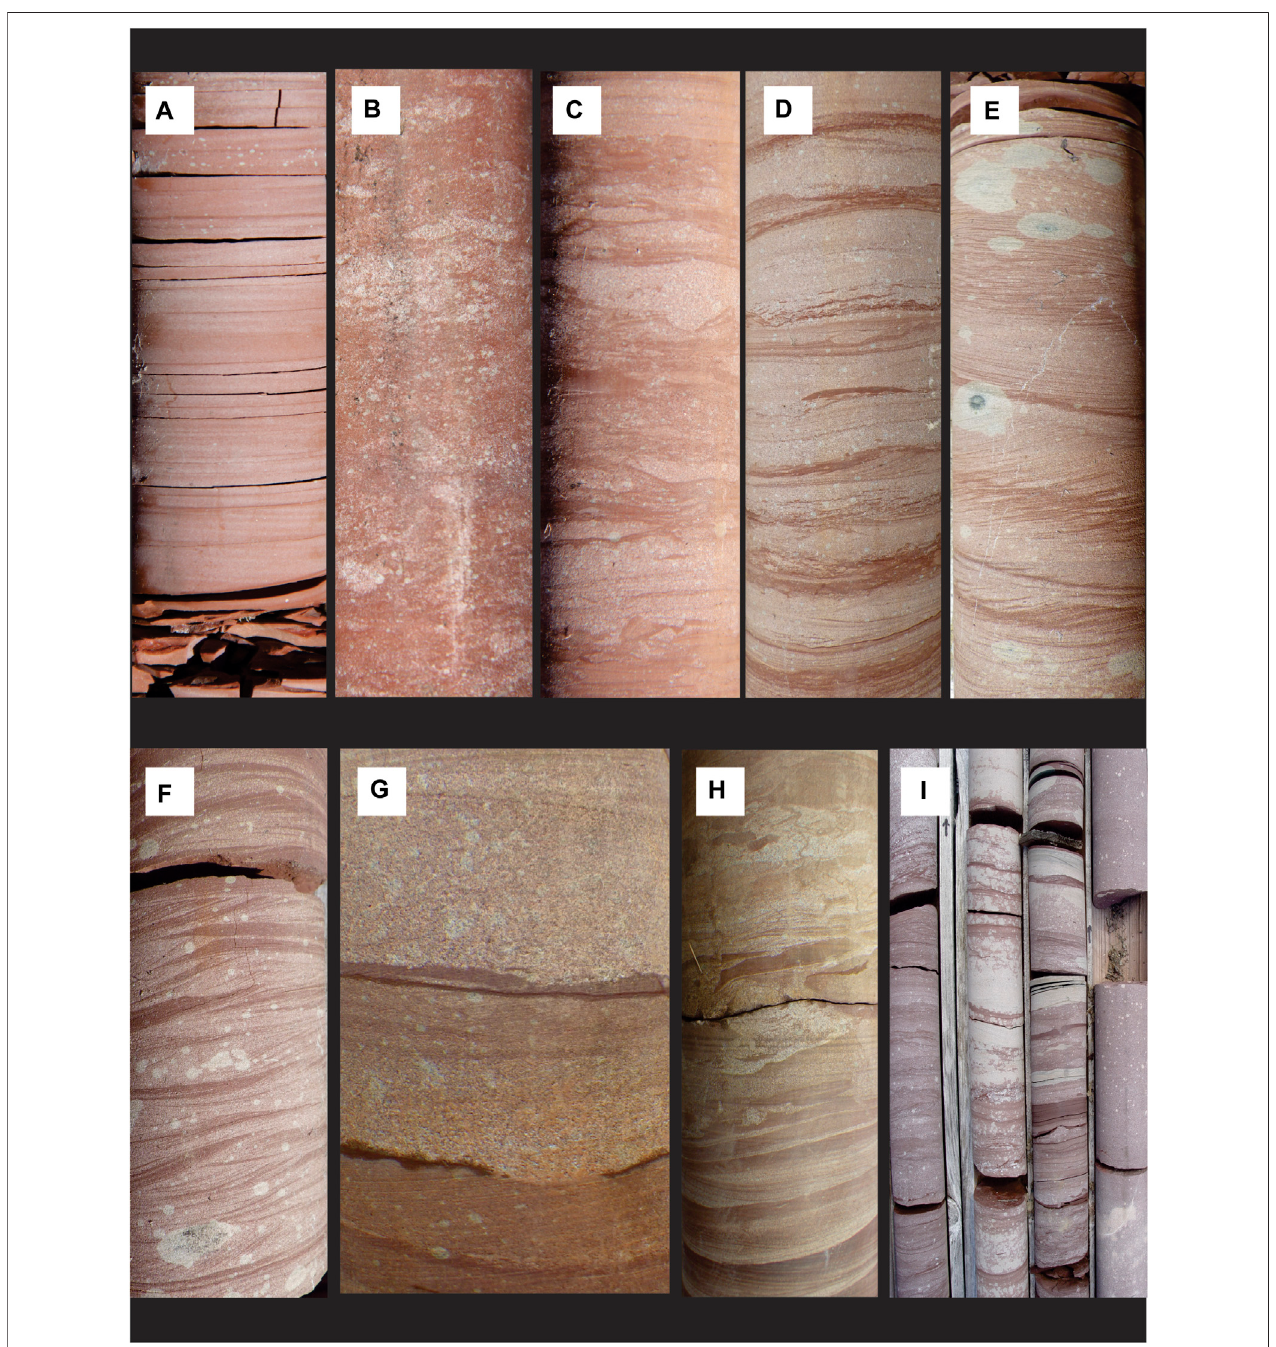
FIGURE5| Lithofaciesthatarecommoninthemiddleandupperportionsoftheloweranduppercoarsening-andthickening-upwardsuccessions.Coreis4.5 cm wide. (A) Less than 1 cm thick layers of parallel laminated siltstone with less than 1 mm thick intervening mudstones. (B) Wispy very fi ne-grained sand in siltstone. (C) Lensoid very fi ne-grained sand in siltstone. (D) Massive and parallel laminated layers of fi ne-grained sandstone interlaminated with current ripple laminated, fi ne-grained sandstone and thin, mudstone drapes. (E) Cross-lamination produced by continuous crested current ripples. The high dip angle of set boundaries denotes rapid sedimentationfromsuspensionduringripplemigration.Silty-clay fl asersanddrapesaccentuatelayering.Theovalmarkisanorganiccoredreductionspot. (F) Lingoidor lunate current ripples with fl asers. (G) Layers of medium-grained sandstone grading to siltstone with drapes of mudstone that were eroded during subsequent fl ow events producing sand-sized clay fl akes in the overlying sandstone. Horizontal lines were produced by drill chatter. (H) Layers grading from fi ne-grained sandstone to siltstone or mudstone overlain by an area of disrupted layering, probably due to water escape. (I) Core younging from bottom left to top right. This is a transitional area near the top of the lower coarsening-upward succession with increasing sand content and layer thickness culminating in thick, medium-grained, massive sandstone layers (e.g. core at the top of the succession at right in this box).